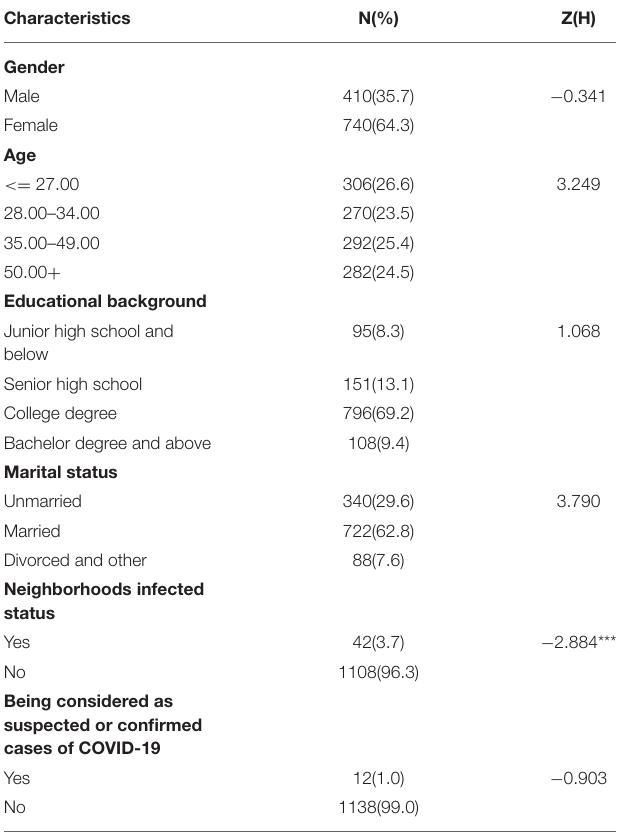
TABLE 1 | Demographica characteristics among